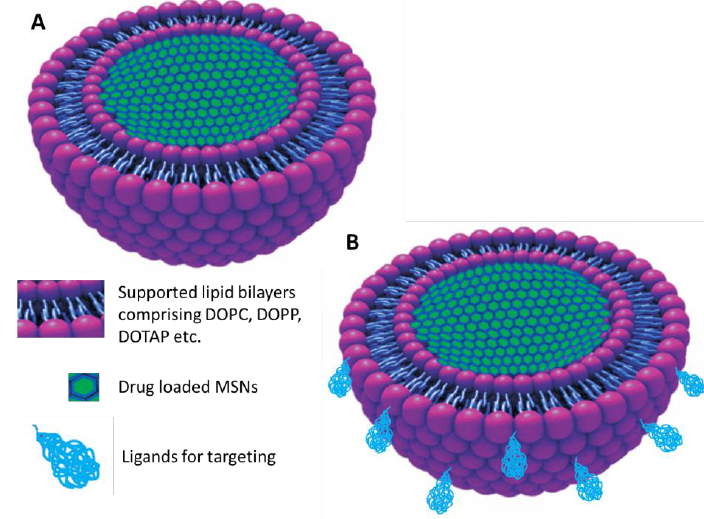
Figure 6. Representation of ( A ) Non-targeted protocell and ( B ) Targeted protocell.